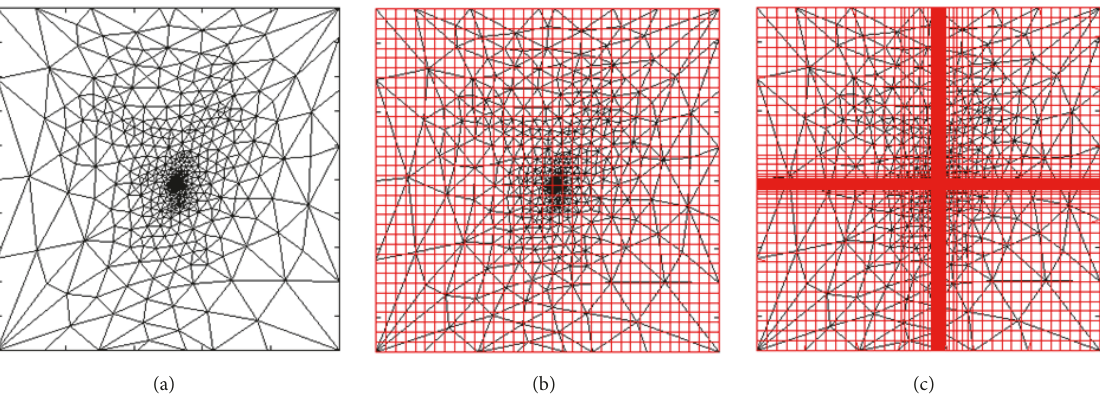
Figure 2: The vertex density equalization based adaptive sampling over venus with sampling rate 𝑛 × 𝑛 . From (a) to (c): the parametrization mesh, the [𝑛/2] × [𝑛/2] regular sampling mesh, and the vertex density equalization based adaptive sampling mesh, with 𝑛 = 70 .